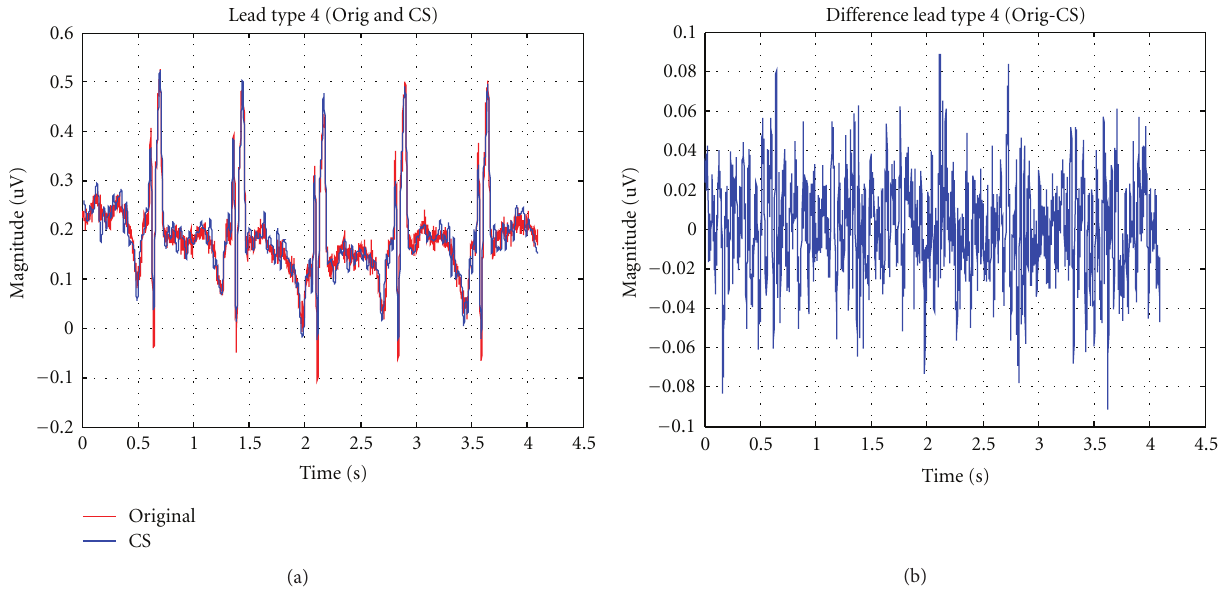
Figure 10: Comparison between the original data and the CS recovering. Figure 10(a) shows lead type 4 at V4, original in blue and the CS in red, where their difference is depicted in Figure 10(b). The difference is less than 0.08